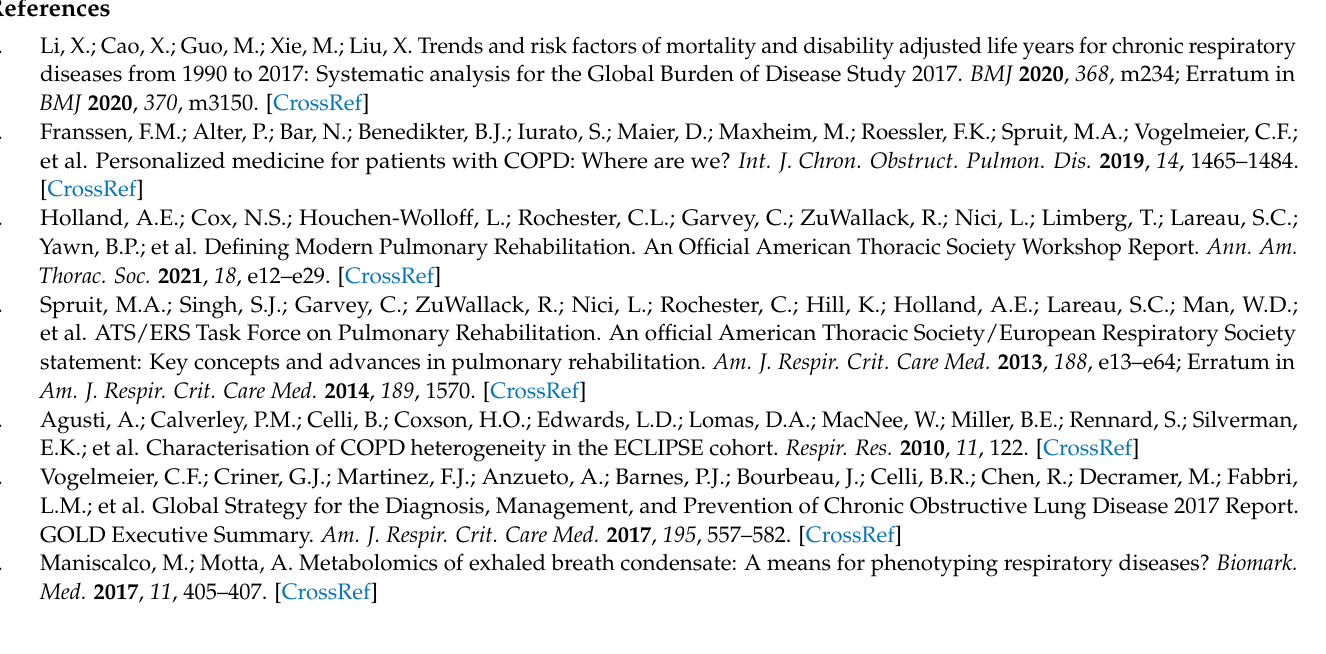
OPLS-DA model; Figure S1: Box-and-whisker plots showing the concentration levels of discriminat- ing metabolites for the T0–T2W–T5W and T0–T5W OPLS-DA models; Figure S2: Box-and-whisker plots showing the concentration levels of discriminating metabolites for the T0–T5W OPLS-DA model; Figure S3: Plots of the YVar values for the three clinical parameters obtained from the OPLS model correlating NMR parameters and clinical outcomes; Figure S4: Coefficient plots correlating metabolites uncovered in the NMR profile of EBC samples and the clinical rehabilitation